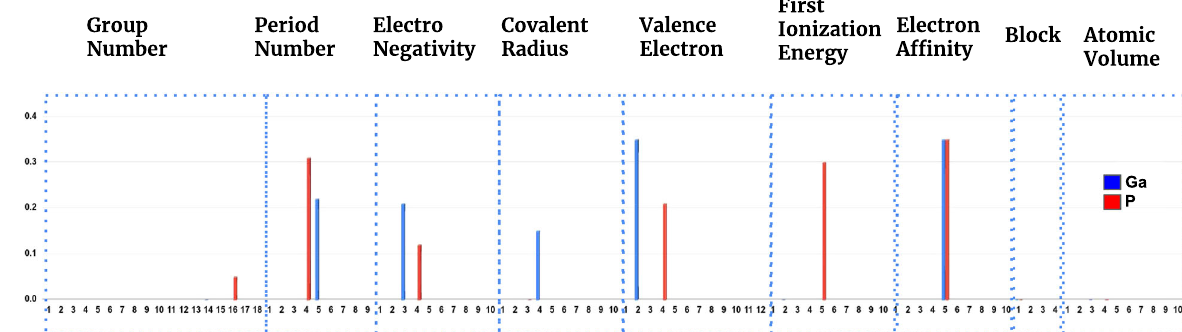
Fig. 5 Feature selector values corresponding to atom features after trained on Band Gap tagged data. The bar chart represents the feature weights of GaP (Band Gap 2.26 eV).